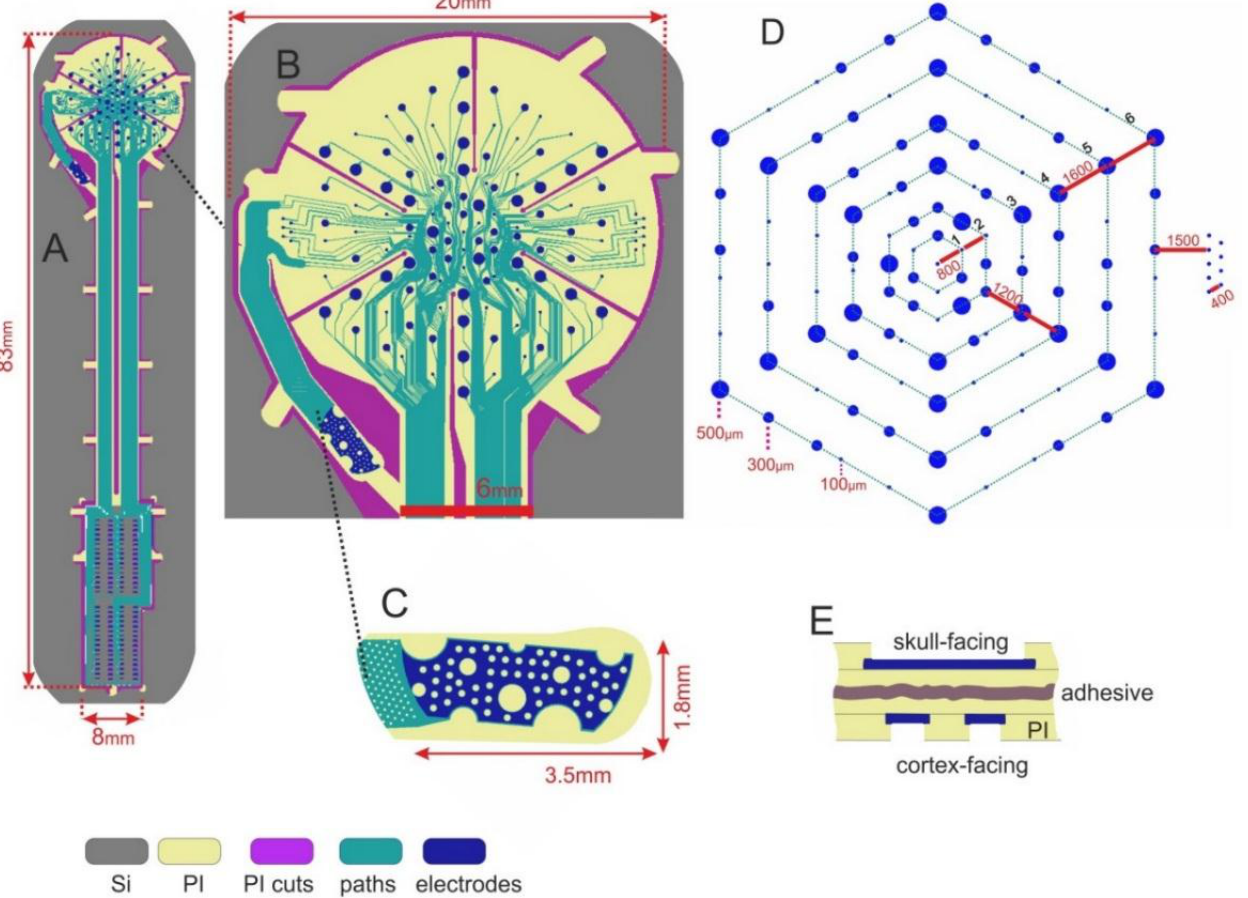
Figure 1. ( A ) ECoG electrode array; ( B , D ) Signal-acquisition area; ( C ) Reference electrode (top-view); ( E ) Reference electrode fixed to the array’s backside